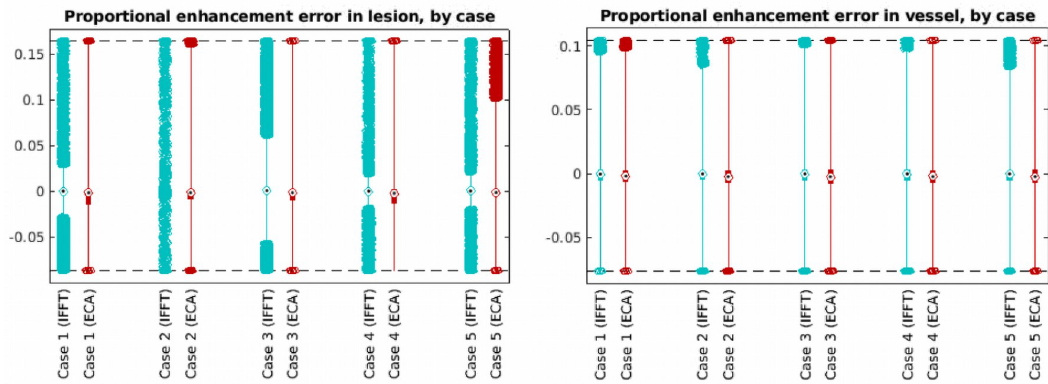
Fig 11. Box and whisker plots of the proportional enhancement error, by case and reconstruction method. Red boxplots (right) are from ECA-reconstructed data; blue boxplots (left) are from standard IFFT reconstructions. Separate plots are shown for lesion and vessel voxels.